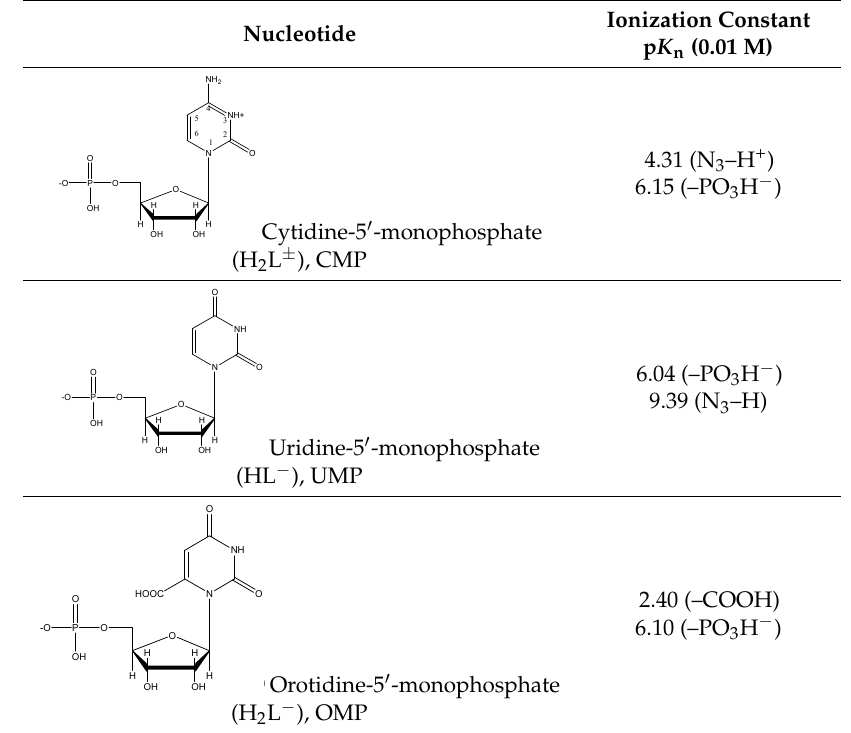
Table 3. Ionization constants of nucleotides [39].